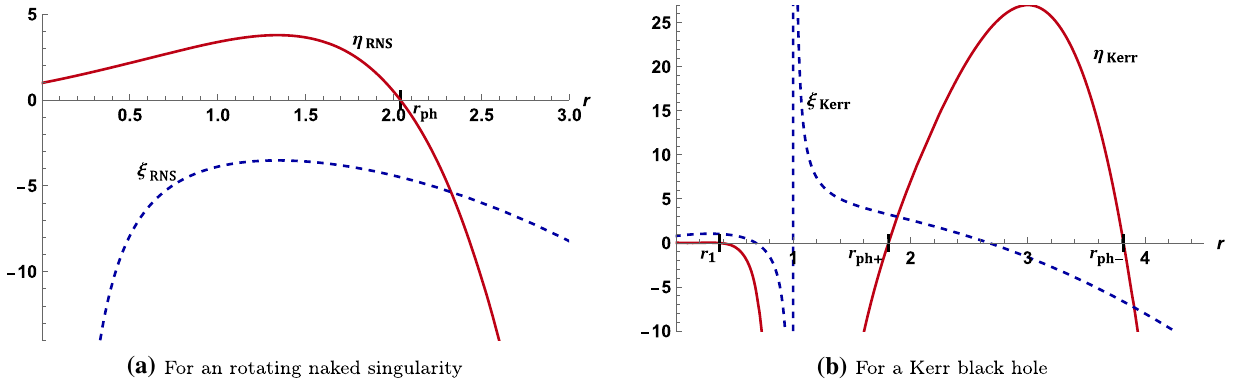
Fig. 2 a , b Demonstrate the behaviour of η and ξ for the RNS and Kerr black hole as a function of radial coordinate r . Here, we consider a = 0 . 8 and M =